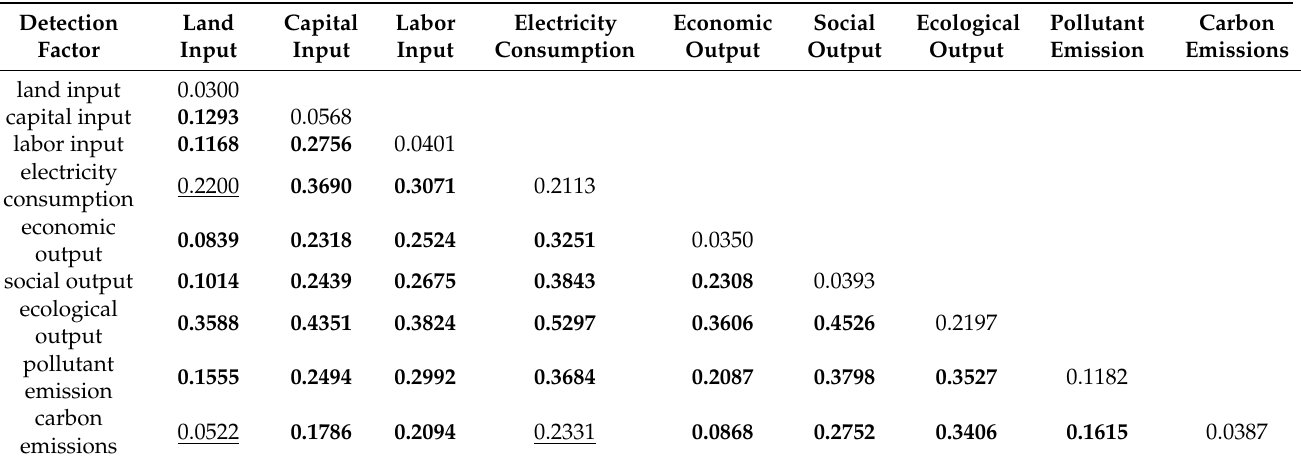
Table 6. Factor detection and interactive detection results for the effect of ULUE on industrial